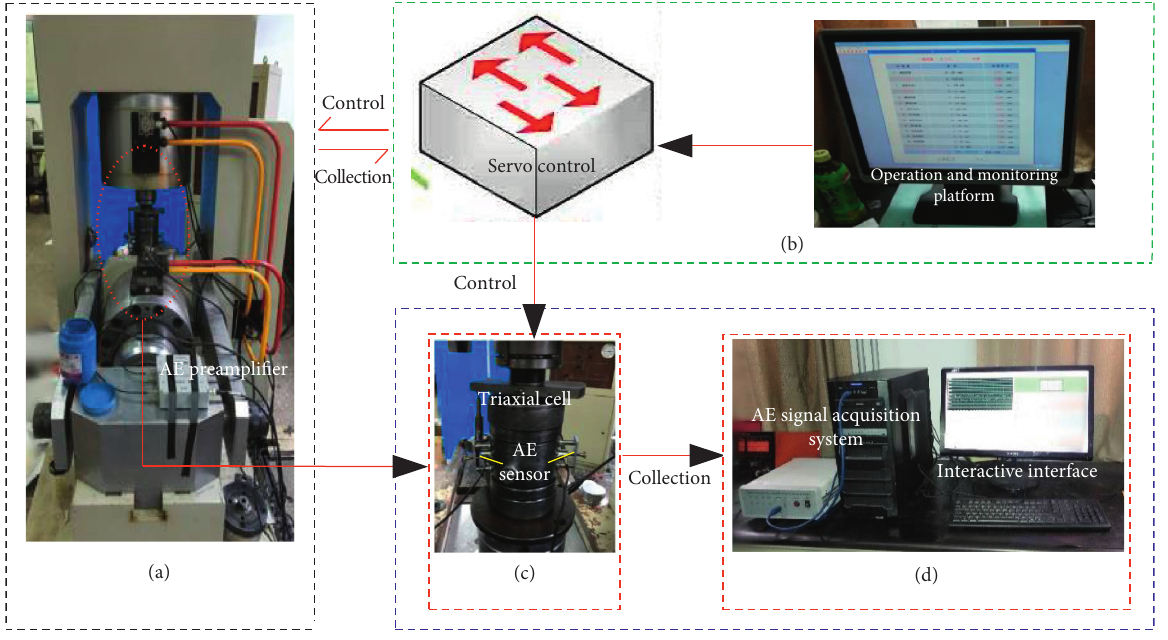
Figure 1: Experimental instruments. (a) RMT-150B rock mechanics test system. (b) Rock mechanics control system. (c) Main part of pressure chamber. (d) Acoustic emission synchronous detection